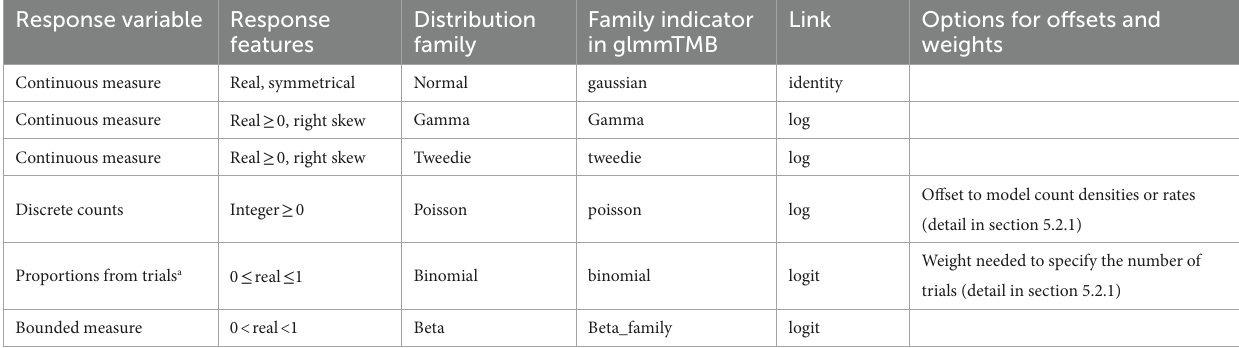
TABLE 1 Recommended response distribution families and link functions for initial model formulation. See Table 2 in section 6 for possible refinements after model